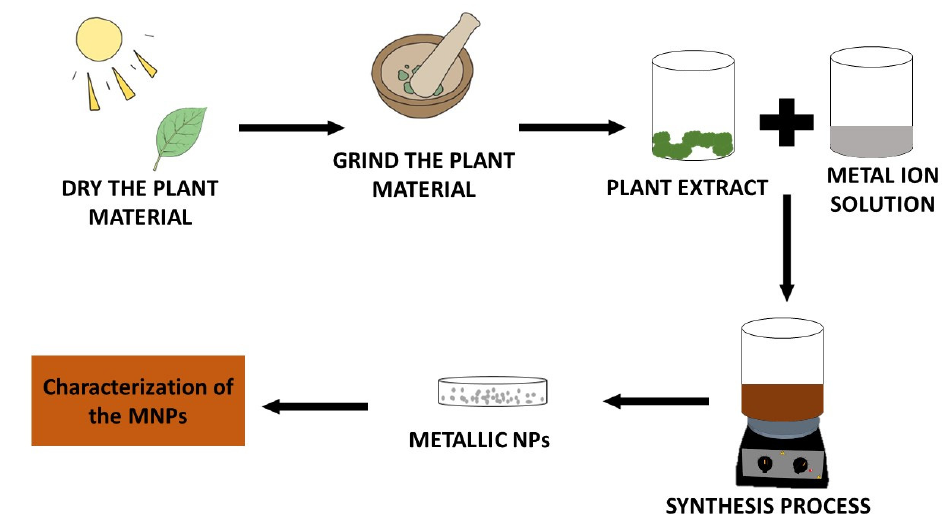
Figure 2. The stepwise flow for the synthesis of MNPs using medicinal plant extract.